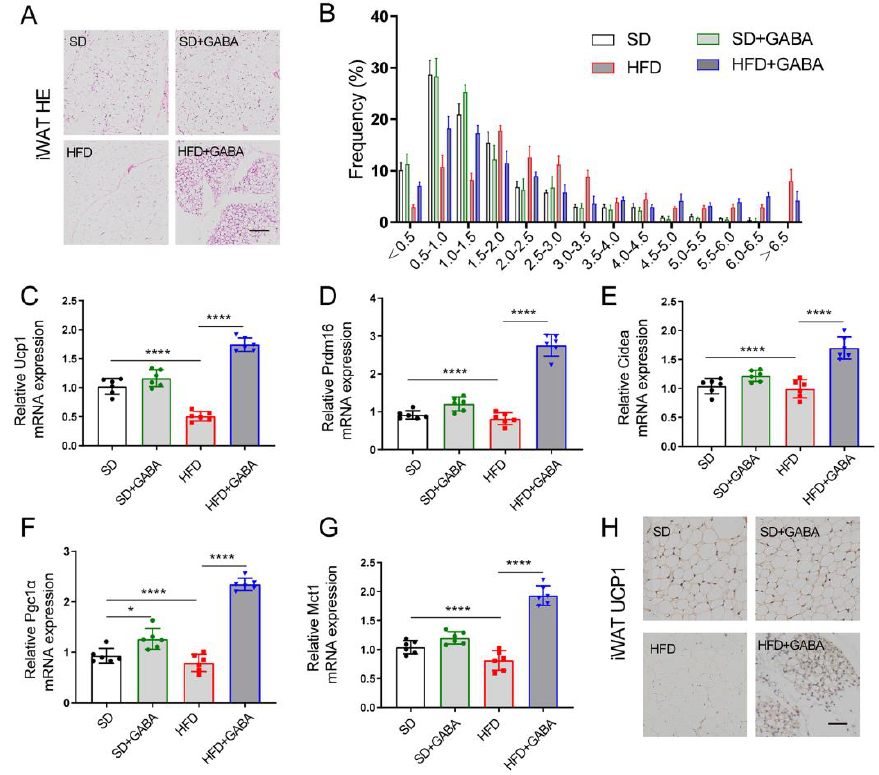
Figure 2. GABA treatment promotes energy consumption through iWAT beiging. ( A ) Representative H&E staining in the iWAT samples (Scale bars 100 μm). ( B ) Area of lipid droplets (*1000μm^2) was estimated using the Image J software. ( C – G ) Expression of thermogenic genes (including Ucp1, Prdm16, Cidea, Pgc1α, and Mct1) in the iWAT. ( H ) Representative UCP1 IHC staining of the iWAT (Scale bars, 50 μm). n = 5–6 for all groups. β-actin as PCR reference gene in ( C – G ). Data are presented as mean ± standard deviation and were analyzed using a one-way or two-way ANOVA. * p < 0.05 and **** p < 0.0001. ANOVA, analysis of variance; iWAT inguinal white adipose tissue.